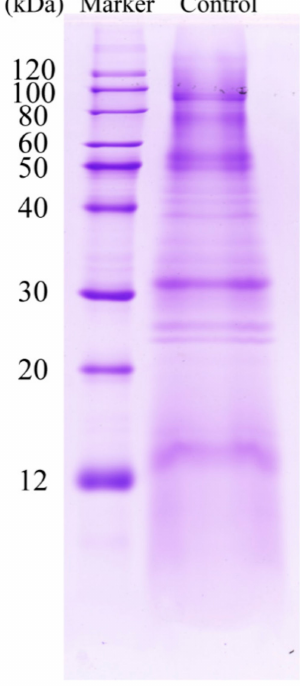
Figure 3. SDS-PAGE electrophoresis of A. flavus surface